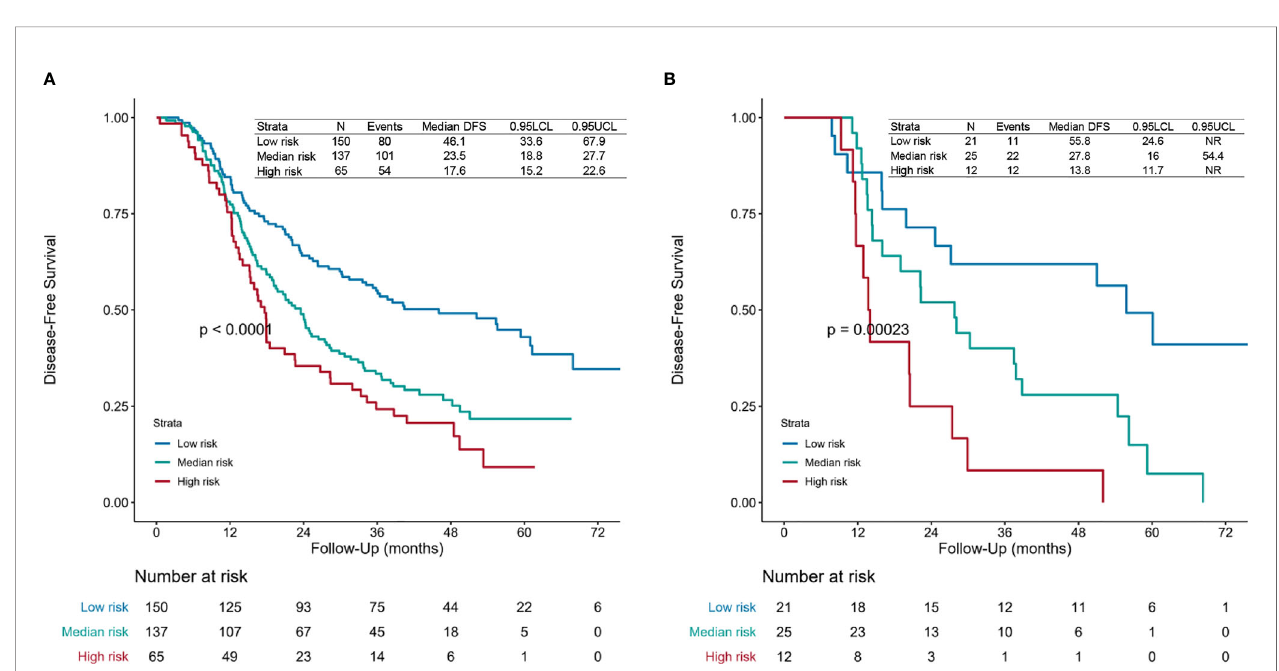
FIGURE 4 | Survival curves. Disease-free survival (DFS) curves for the (A) primary cohort (training set and validation set 1) and (B) validation cohort (validation set 2) of patients receiving four or more postoperative chemotherapy cycles and postoperative radiotherapy of each risk group. The risk points for each patient were calculated based on the nomogram ( Figure 1 and Supplementary File 1 ). All patients were divided into three subgroups applying the de fi ned cutoff value, named low-risk group (risk point: 0 – 226), median-risk group (risk point: 226 – 306), and high-risk group (risk point: 306 – 466). The patients-at-risk table is displayed at the bottom of the plots. NR, not